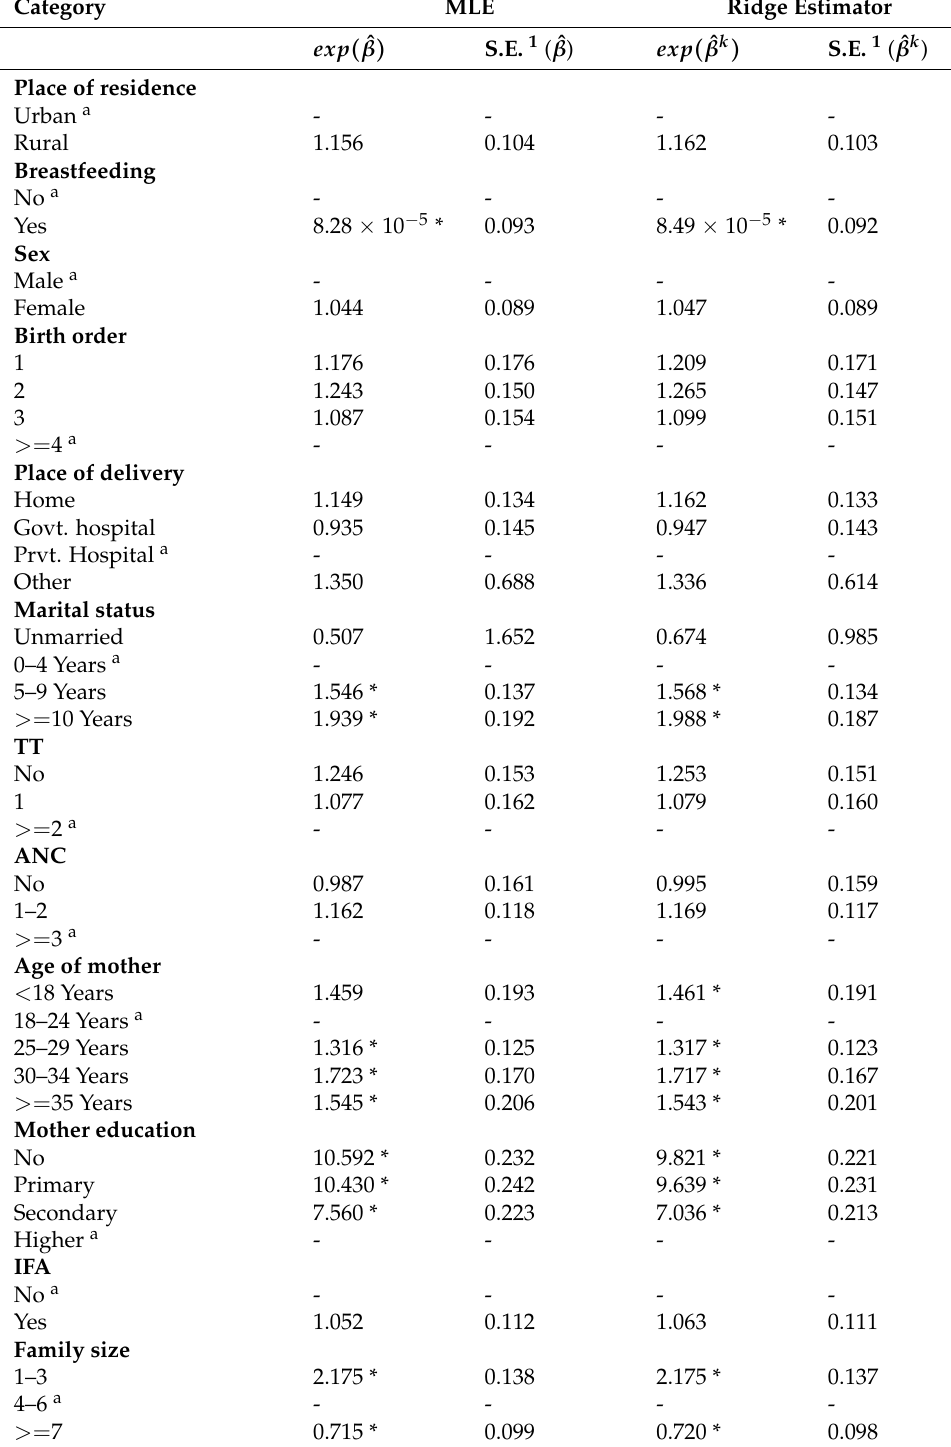
Table 5. Estimation in frailty